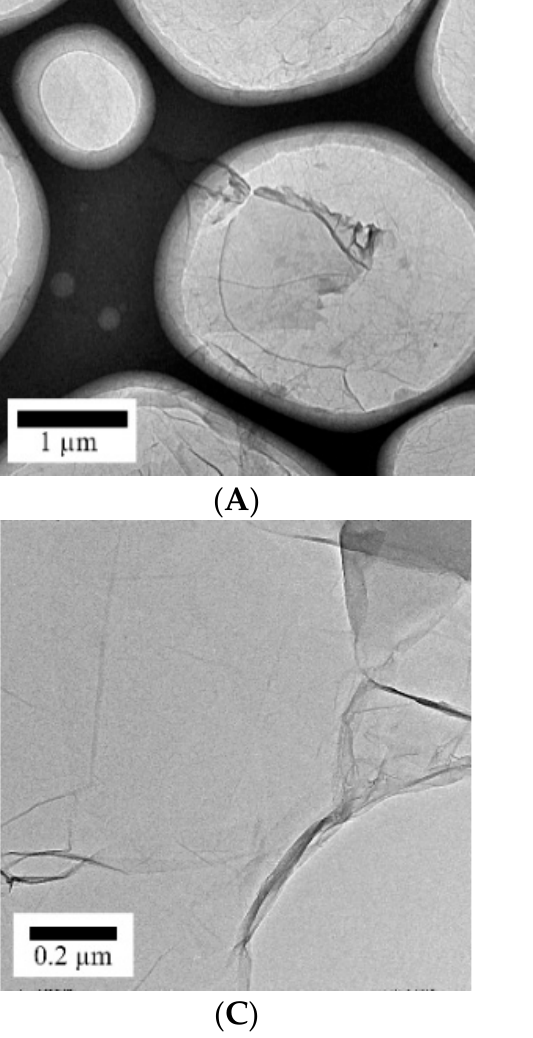
Figure 1. The morphologies and structures of GO, RGO, RGO_PDDA, and CQDs. TEM images of ( A ) GO, ( B ) RGO, ( C ) RGO_PDDA, and ( D ) HRTEM image of CQDs.